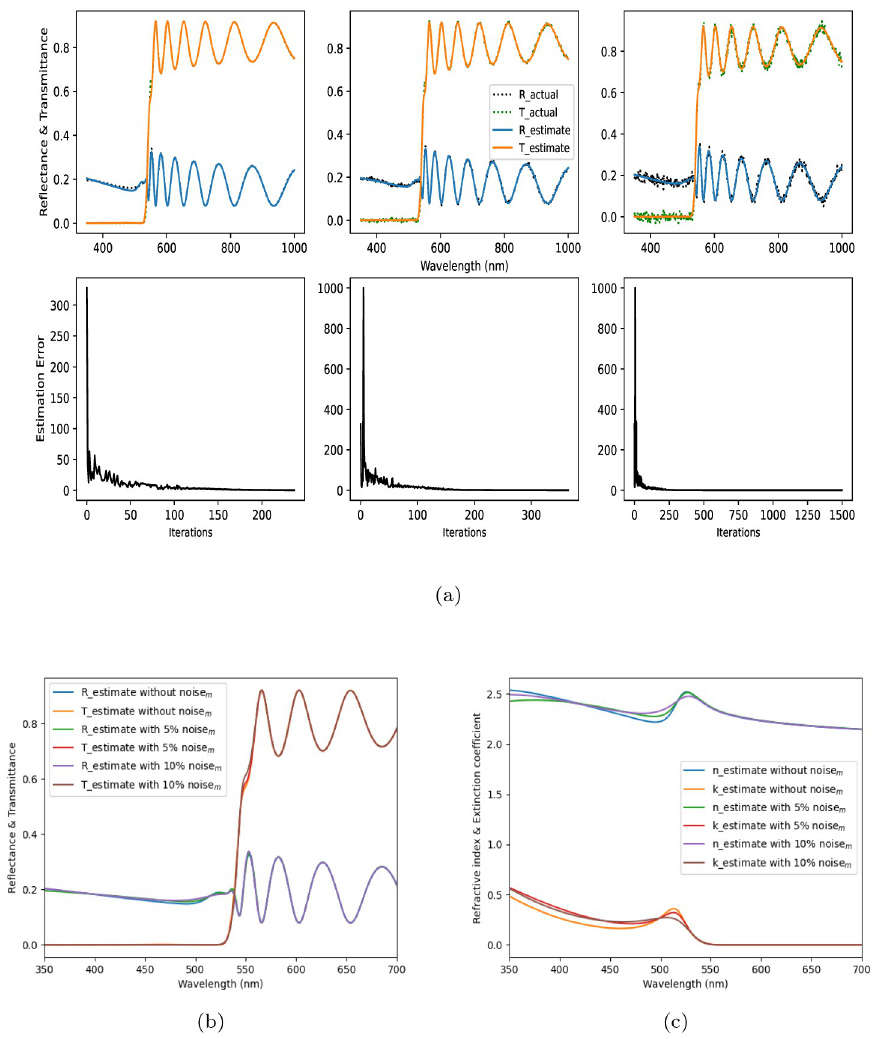
Fig 5. Effect of measurement noise in estimation performance: (a) The top rowpresents noisy spectral data references and estimates, and the bottom row presents the evolution of estimation errors with iterations; the reference and the estimated reflectance and transmittance are in good agreement with each other. The noise level increases from left to right column-wise as 0%, 5%, 10% noise m , respectively (b) Estimated spectra vs. wavelength, (c) Estimated optical constants vs.